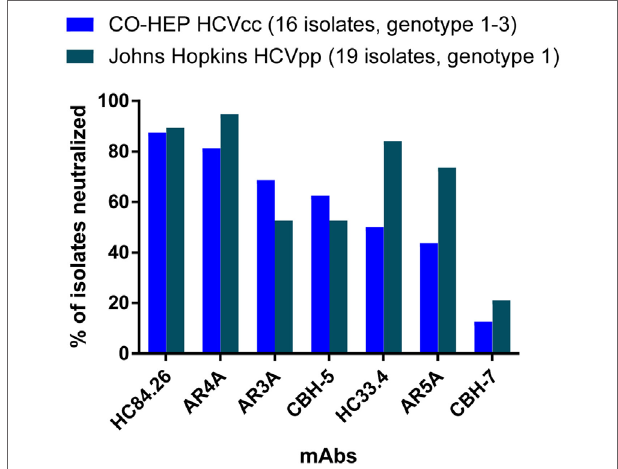
FiGURe 2 | Neutralizing breadth of seven monoclonal antibodies measured using HCV cell culture (HCVcc) and HCV pseudoparticle (HCVpp) panels. Values shown are the percentage of 16 genotype 1–3 HCVcc isolates from the Copenhagen Hepatitis C Program (CO-HEP) neutralized with an IC 50 less than 10 µg/mL (74), or the percentage of 19 genotype 1 HCVpp isolates from Johns Hopkins University neutralized more than 50% by 10 µg/mL of mAb